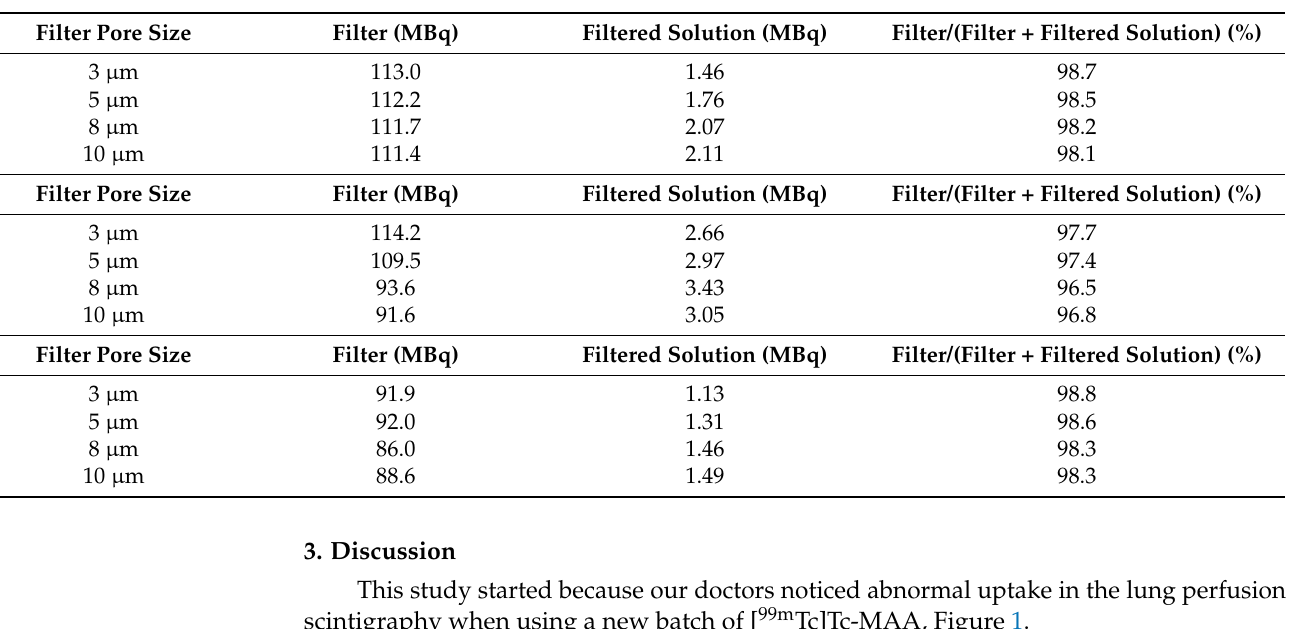
Table 3. Table showing filter test results from three [ 99m Tc]Tc-MAA preparations from Pulmocis labelling kits.